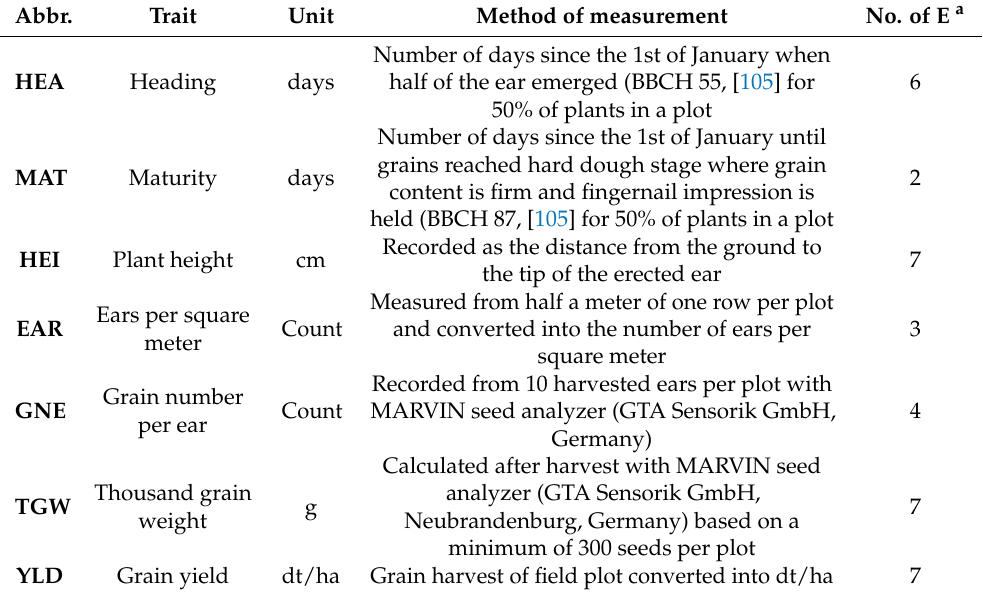
Table 5. List of seven evaluated